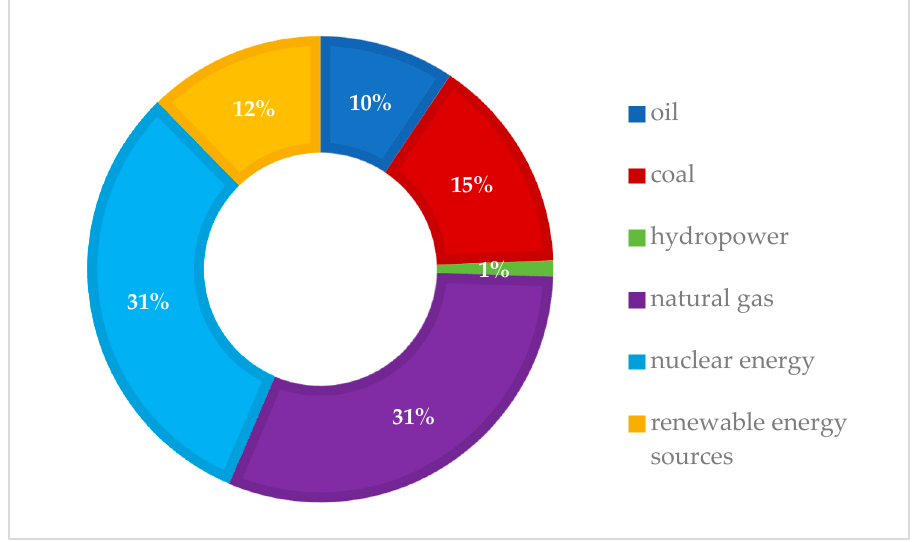
Figure 11. Forecast of energy balance in 2028 (Ukraine). Source: [55].